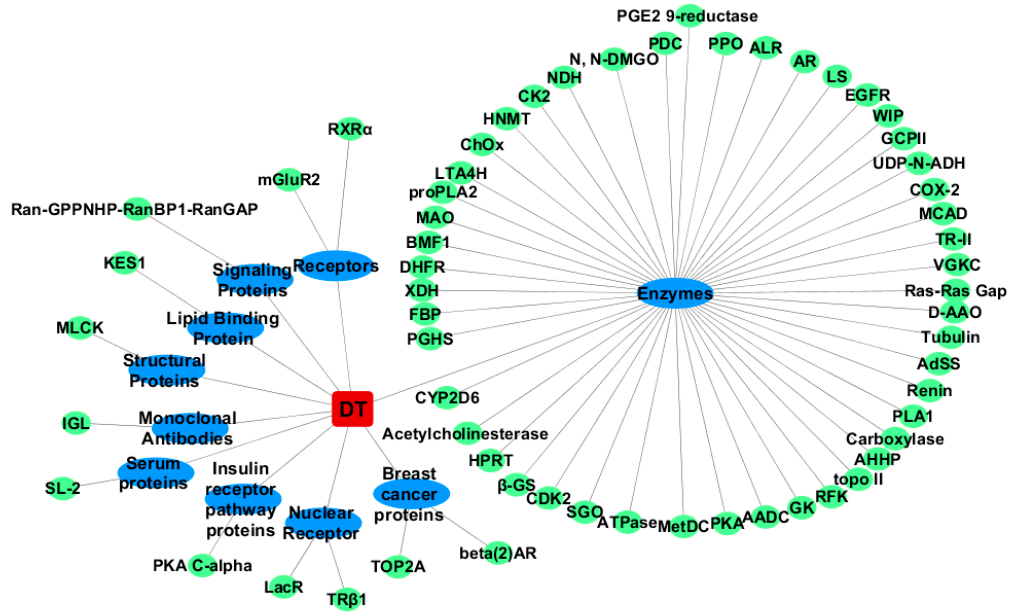
Figure 2. The network of TDT and the screened targets.